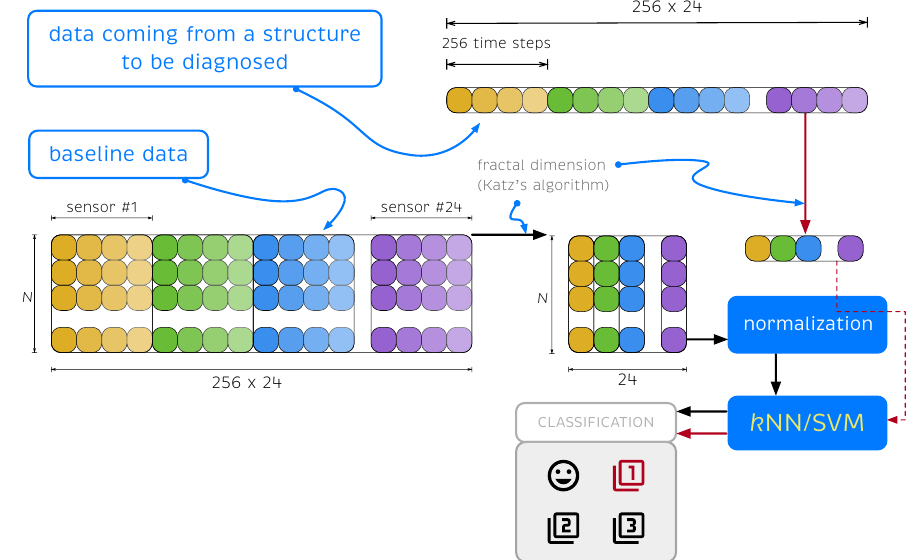
Figure 5. Flowchart summarizing the proposed damage diagnose strategy.